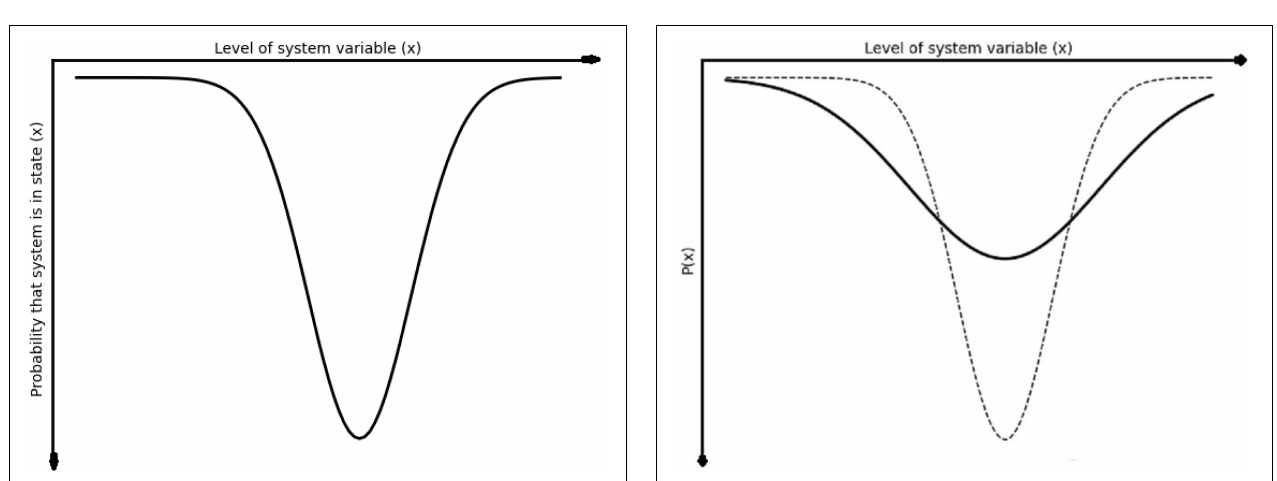
FIGURE 1 | A basin of attraction (an inverted normal curve) following Tschacher and Haken (2019), indicating a distribution of probable states of the system variable (x) – or P(x), with the most likely state being at the bottom of the basin.